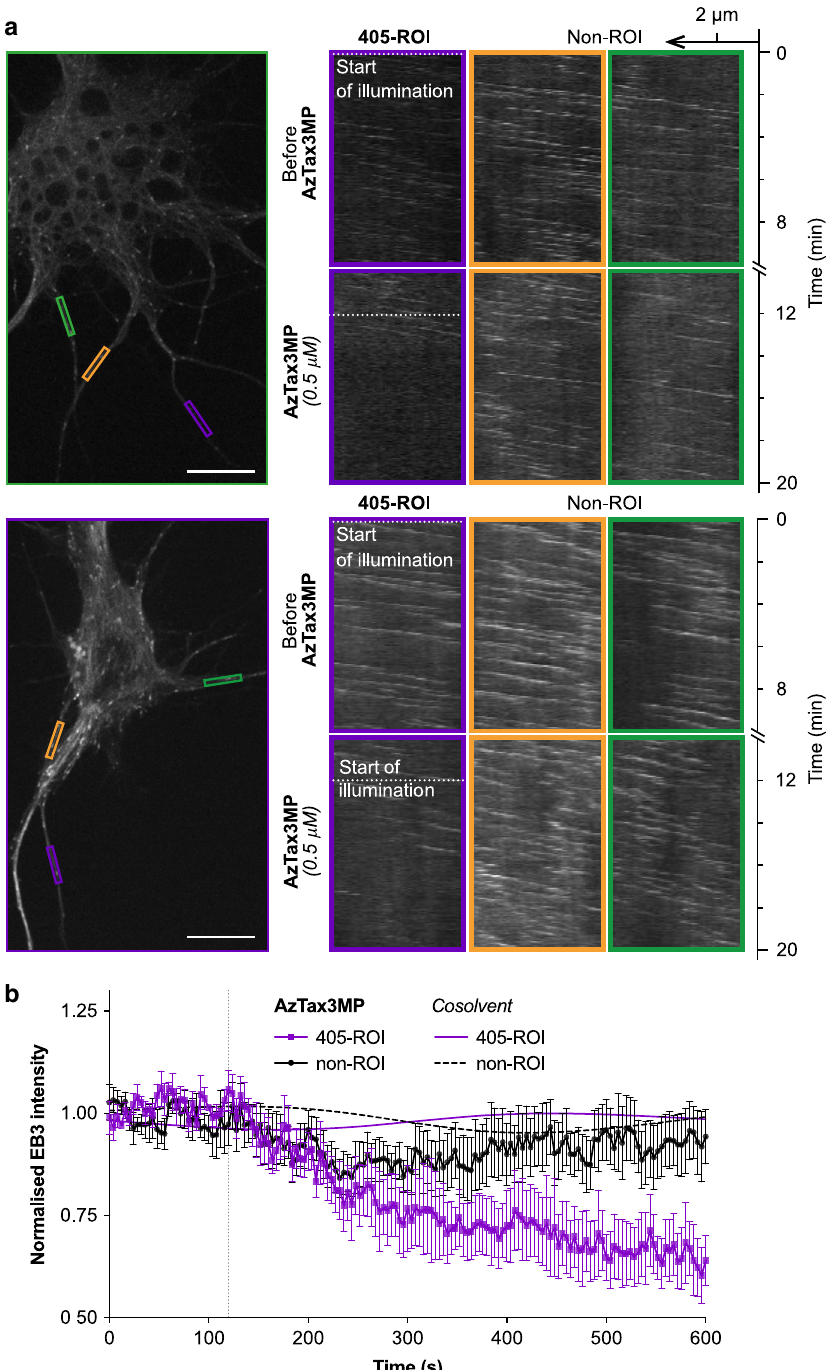
Fig. 6 Manipulation of MT polymerisation dynamics in subcellular ROIs of rat primary hippocampal neurons using AzTax3MP. Data related to Supplementary Movies 5 – 8. a , b Cultured primary neurons (9 days in vitro) transfected with EB3-tdTomato treated with 1% DMSO were initially imaged for EB3 for 10 min while a ROI (violet box) was pulsed with 405 nm light, establishing baselines for EB3 activity in the cell and in the ROI, which were demonstrated to be light-independent. The same neurons were then exposed to 0.5 µ M AzTax3MP and immediately imaged for another 10 min; during this time the same ROI (violet box) was pulsed with 405 nm light beginning at 2 min into the acquisition (indicated by dotted lines). a Cell images with areas marked, and corresponding kymographs of these areas. The ROI pulsed with 405 nm is boxed in violet, the non-ROI areas (not pulsed with 405 nm) are boxed in orange and green. Scale bars indicate 10 µ m. b Normalised area-average pixel EB3 intensities (with s.e.m.), for areas treated with or without AzTax3MP and 405 nm pulsing ( n = 4 cells). For clarity, data for cosolvent-only areas are shown as spline fi ts; see Supplementary Note 4 for further